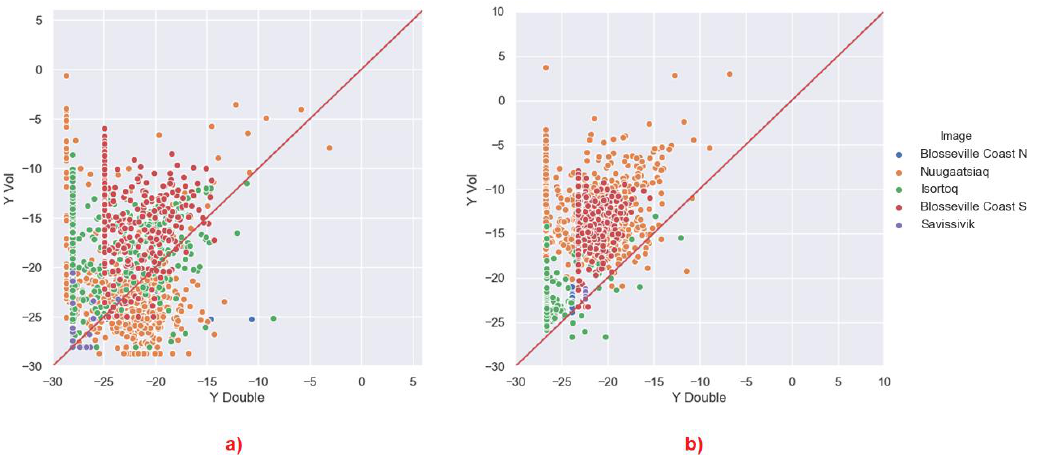
Figure 23. ( a ) Iceberg double bounce scattering, volume scattering plot in a 5 × 5 window, ( b ) 11 × 11 window. The majority of icebergs show volume scattering. Colour legend indicates image. Dots indicate icebergs. All values are in dB.